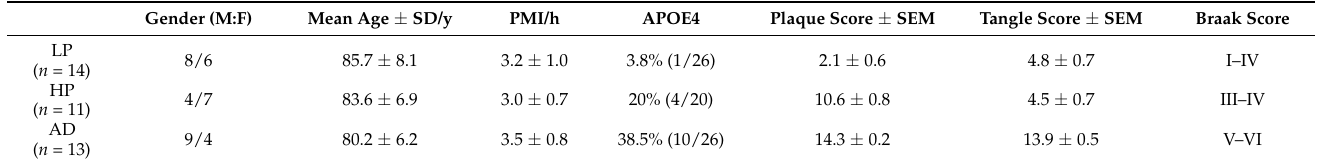
Table 1. Demographic details of human brain middle temporal gyrus (MTG) cases employed in immunohistochemistry studies. Series 1 (Abbreviations: LP, low-plaque non-demented; HP, high- plaque non-demented; AD, Alzheimer’s disease; M:F, male:female numbers; SD, standard deviation; PMI, postmortem interval; APOE4, percentage and numbers of cases with APOE4 genotype; SEM, standard error of mean).